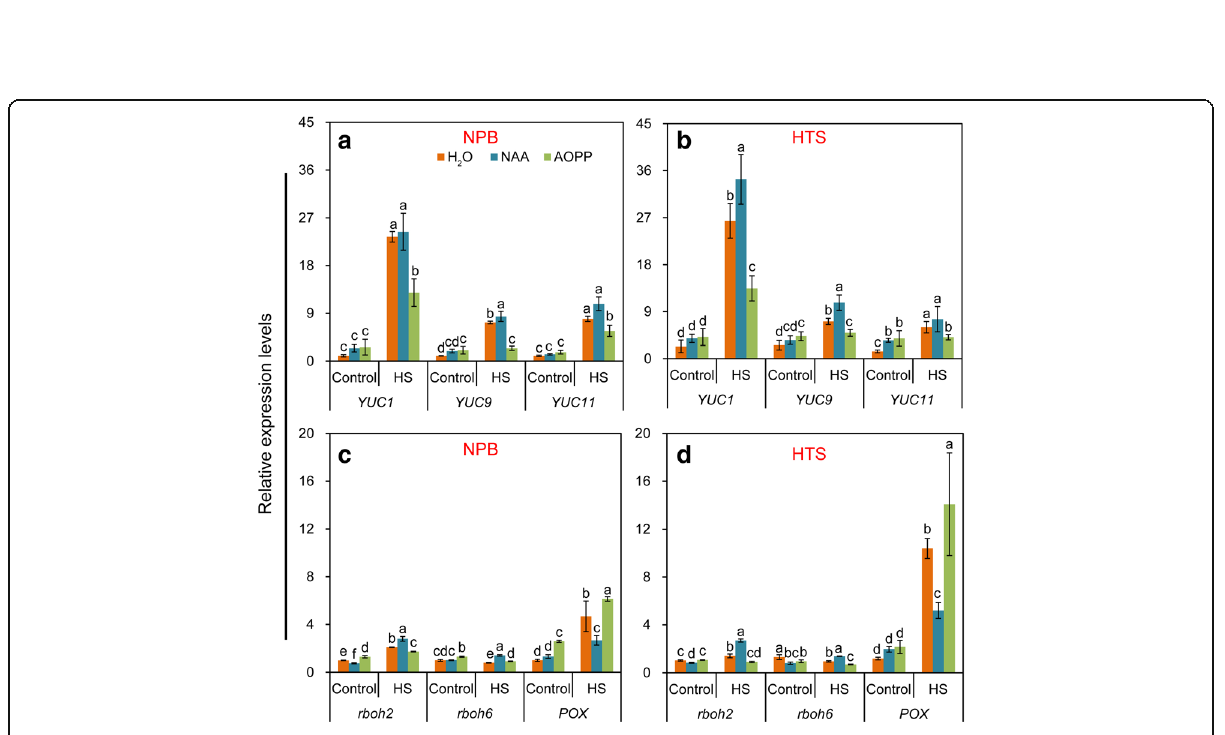
Fig. 5 Expression levels of the YUC genes, rboh genes, and POX gene in rice pistil. a and b YUC genes in NPB and HTS, respectively; c and d rboh genes, and POX gene in NPB and HTS, respectively . Vertical bars denote the standard deviation ( n = 4). Different letters indicate significant differences between control and heat stress treatments ( P <